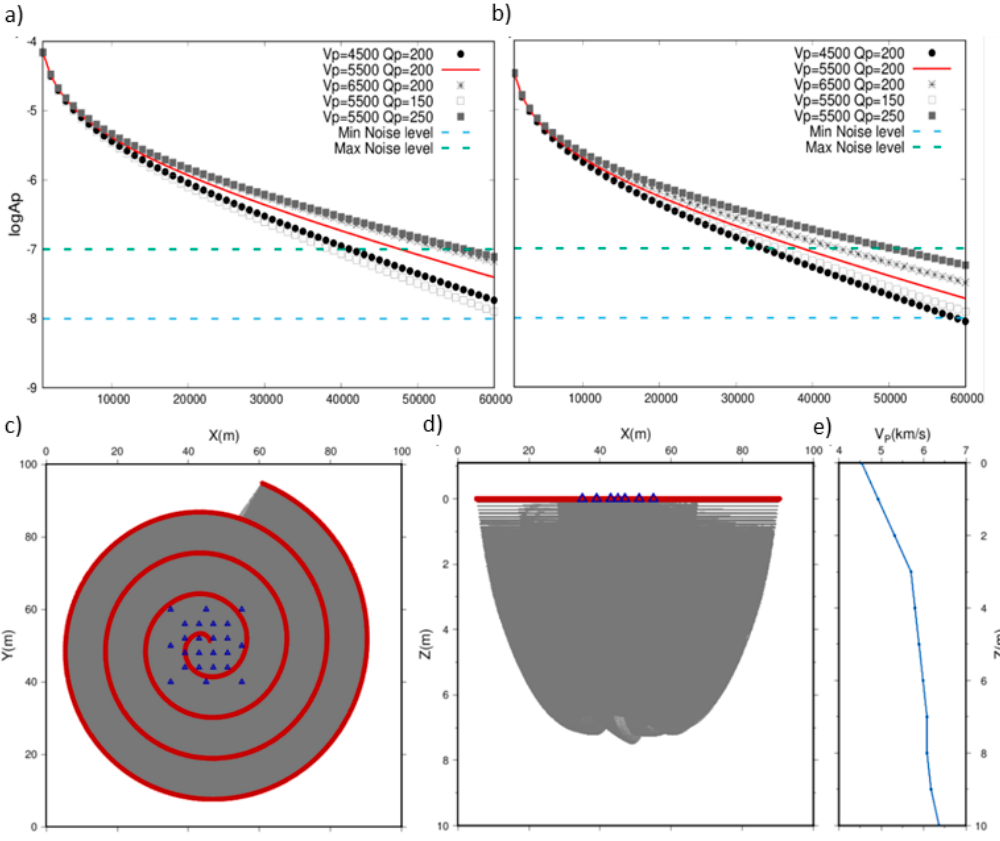
Figure 3. Active survey set-up: Layout set-up + ray tracing in XY ( a ) and in XZ ( b ), the red dots represent the sources and the blue triangles the stations. 1D velocity model ( c ). Attenuation curves in the case of a soft ( d ) and a hard ( e ) sea bottom.